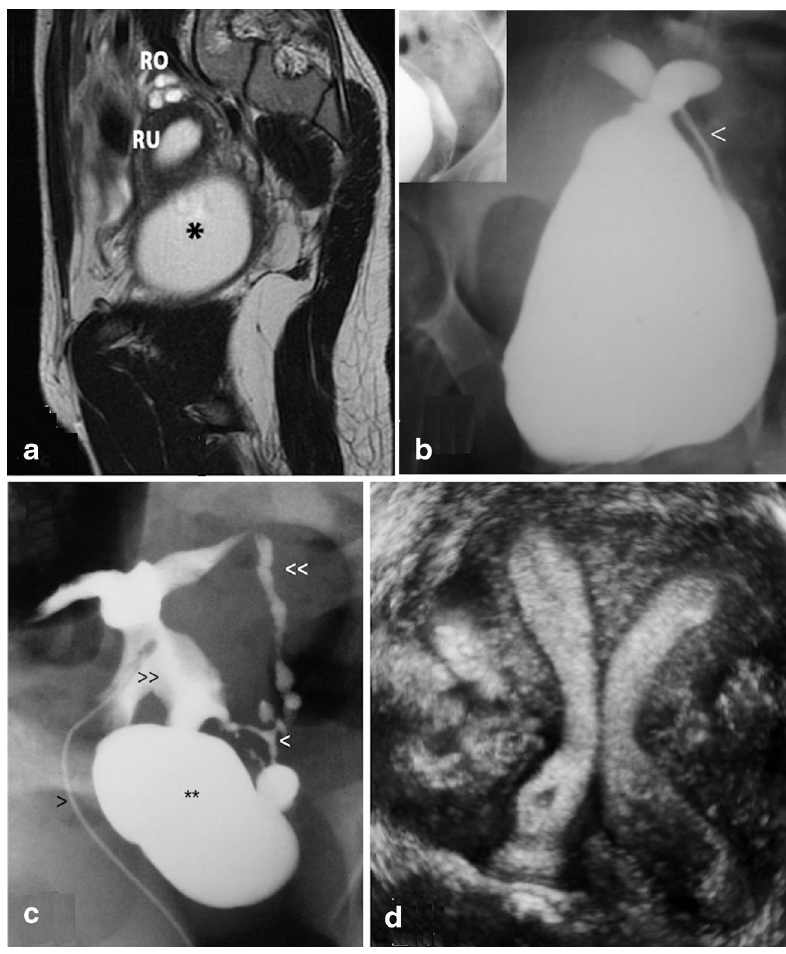
HSG image obtained with a small Foley catheter (>) showing the findings in a patient who underwent previous adhesiolysis and Strassman operation abroad. Left blind hemivagina (**), communicating uteri (>>), left ectopic ureter (<<) and possible mesonephric remnants (<) can be observed (modified from Acién et al., Eur J Obstet Gynecol Reprod Biol 2004;117:105 – 108, with permission). d Three-dimensional ultrasound image showing a septate uterus and left blind hemivagina (now perforated) 1 year after drainage of haematocolpos and haematometra (courtesy of Dr. M. Sánchez - Ferrer,